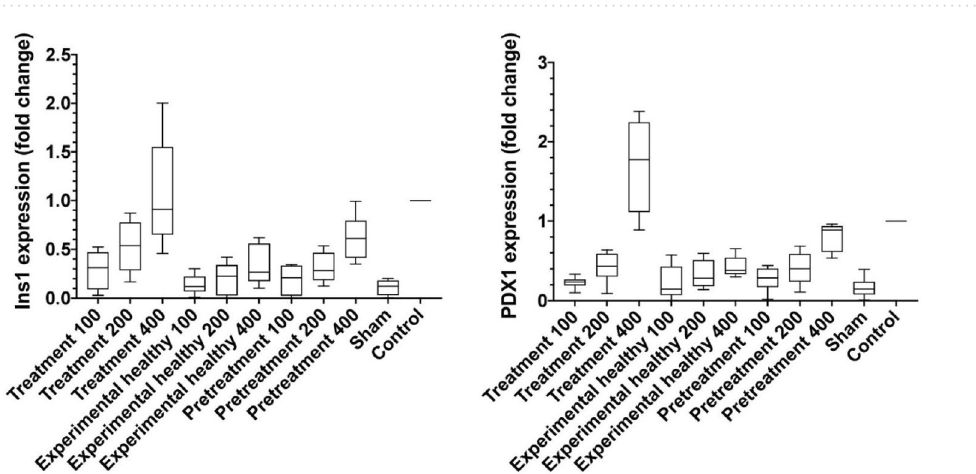
Graph 1. The results of gene expression.